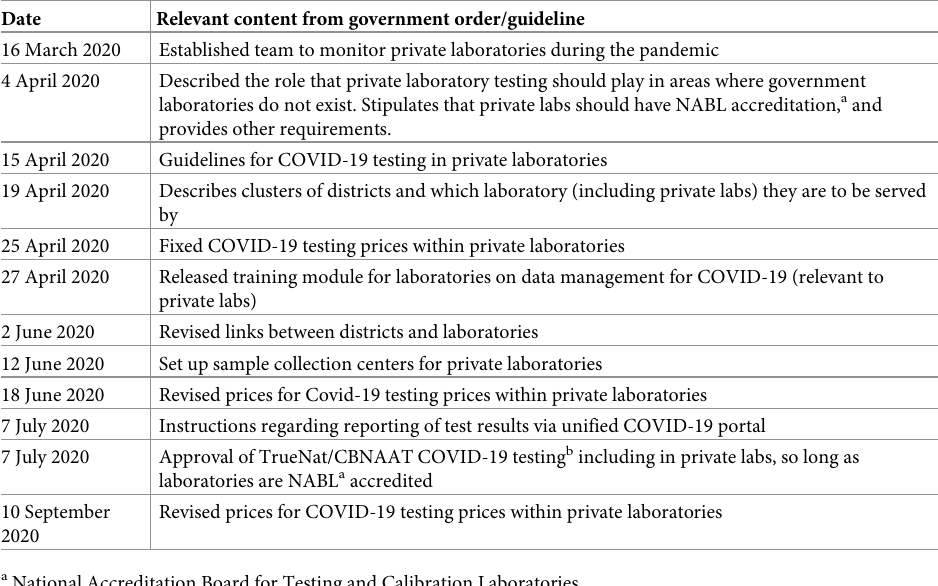
Table 4. Summary of relevant government orders from March-September 2020 describing the engagement of the private laboratories in the COVID-19 response in Uttar Pradesh,